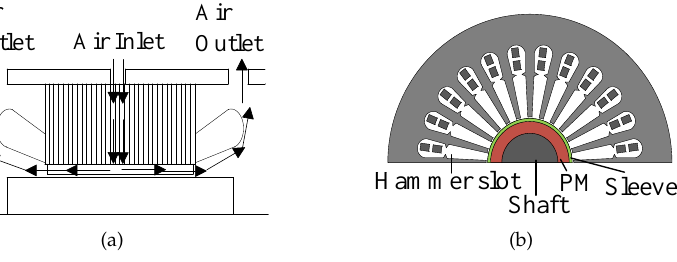
Figure 17. Cooling structure: ( a ) The structure of mixed ventilation [102]; ( b ) The structure of “hammer slot type” [56].